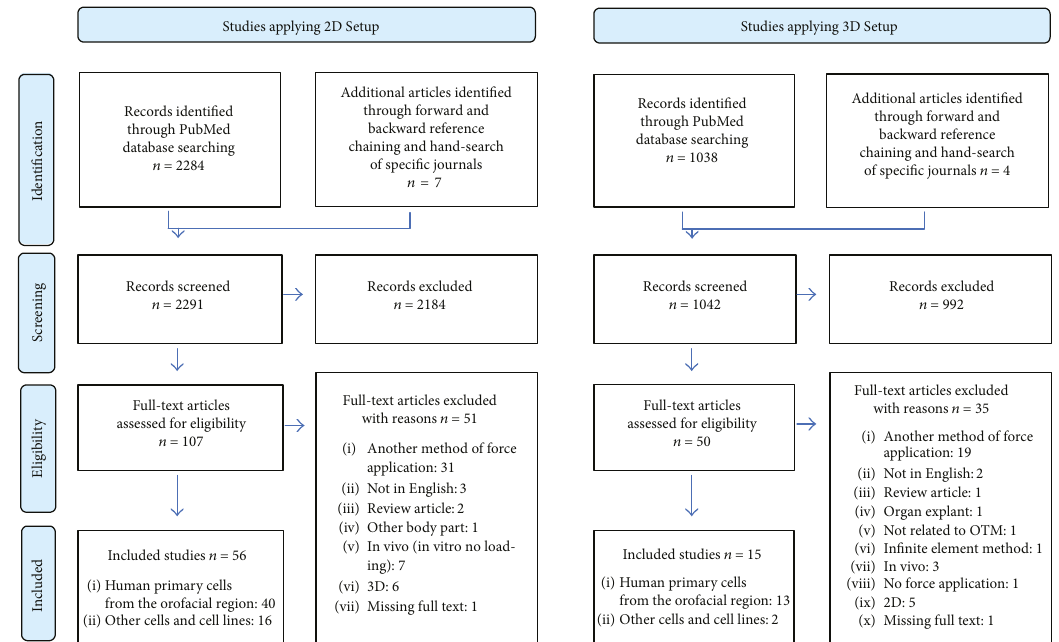
Figure 3: PRISMA fl ow diagram of the review